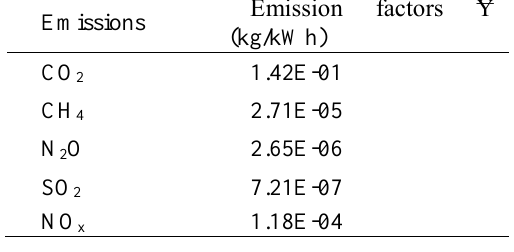
Table 2. Electricity Emission Factors Based on the Power Mix in the National Grid